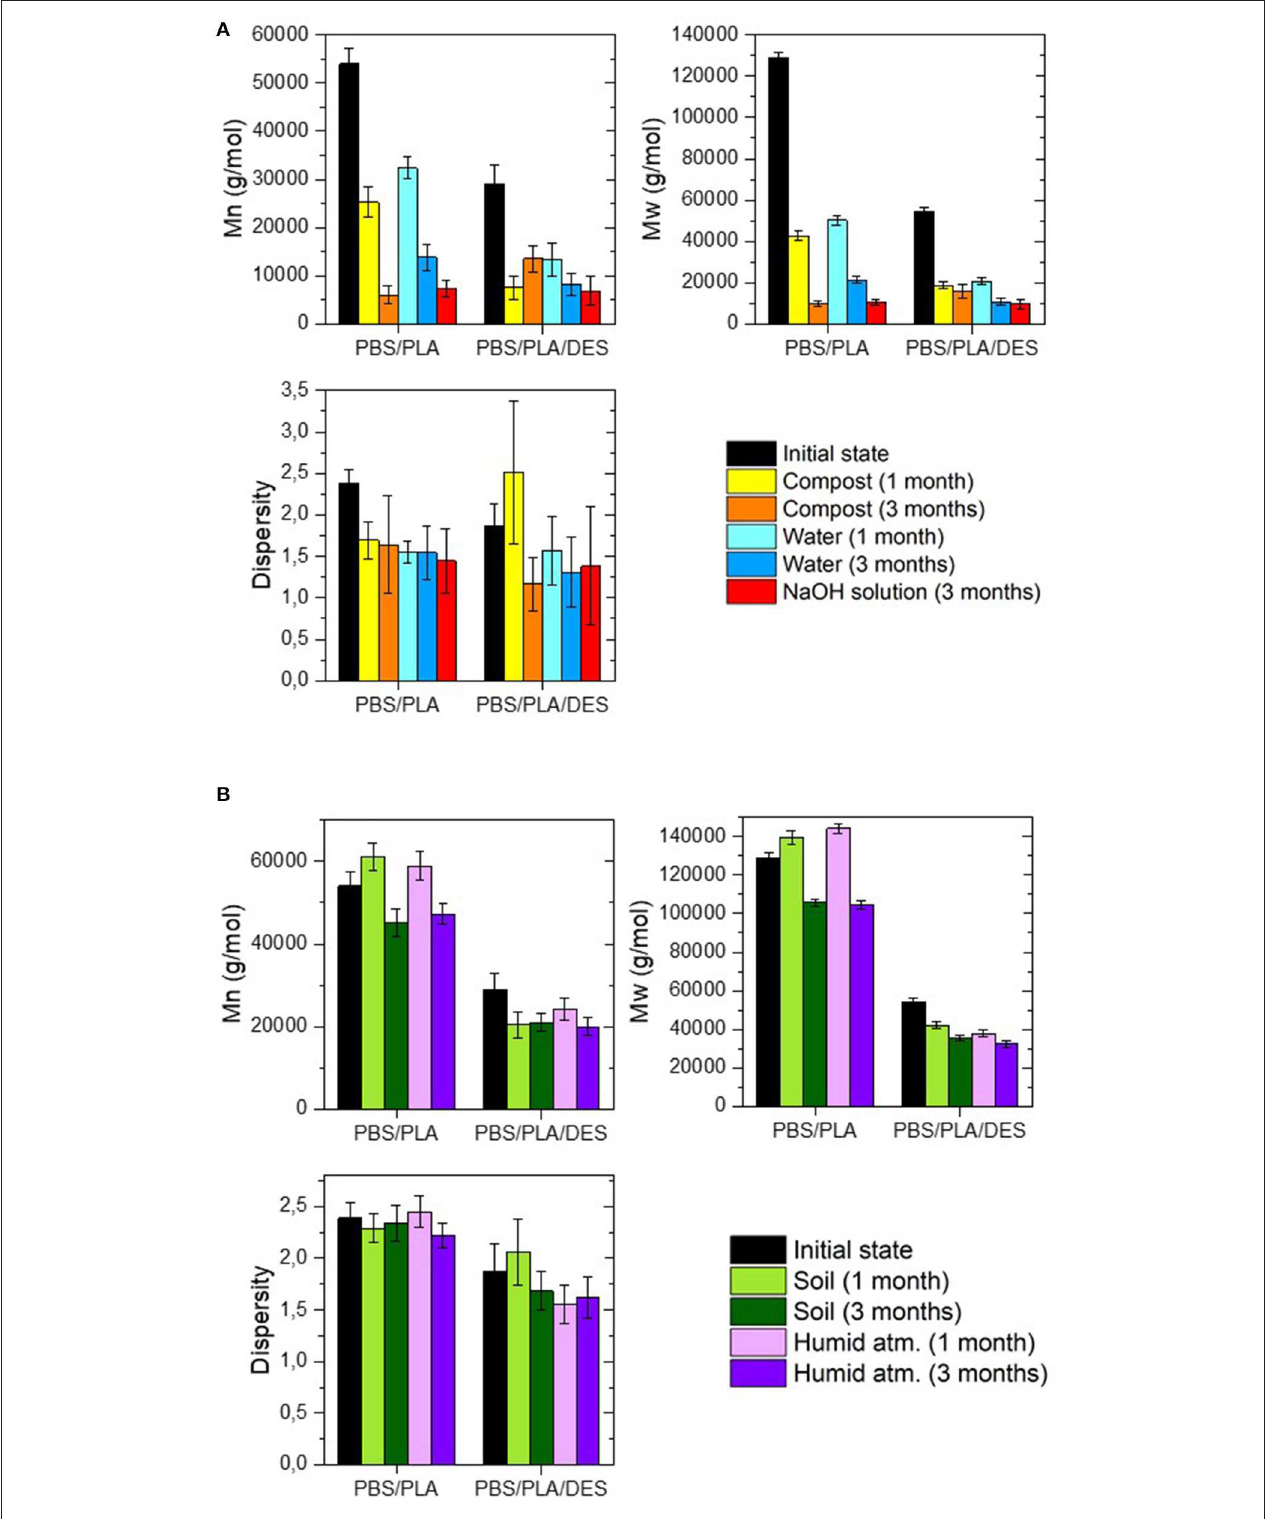
FIGURE 7 | M n , M w , and dispersity of poly(butylene succinate) (PBS)/poly(lactic acid) (PLA) blends measured with CHCl 3 -deep eutectic solvents (DES), after degradation under composting conditions, in water, and in NaOH solution at 58 ◦ C (A) , and under soil burial conditions and in humid atmosphere at room temperature (B)